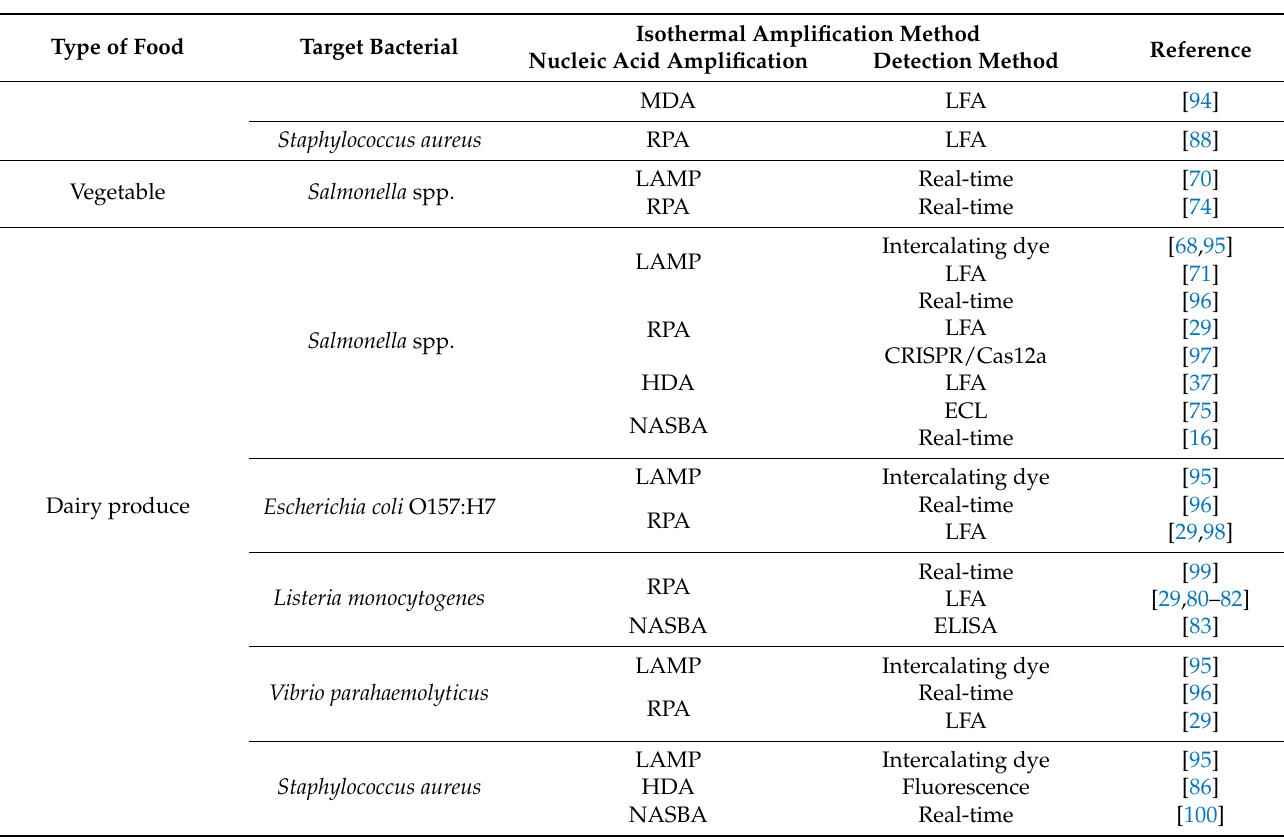
Abbreviations used in the table: LAMP, loop-mediated isothermal amplification; RPA, recombinase polymerase amplification; HDA, helicase-dependent amplification; NASBA, nucleic acid sequence-based amplification;